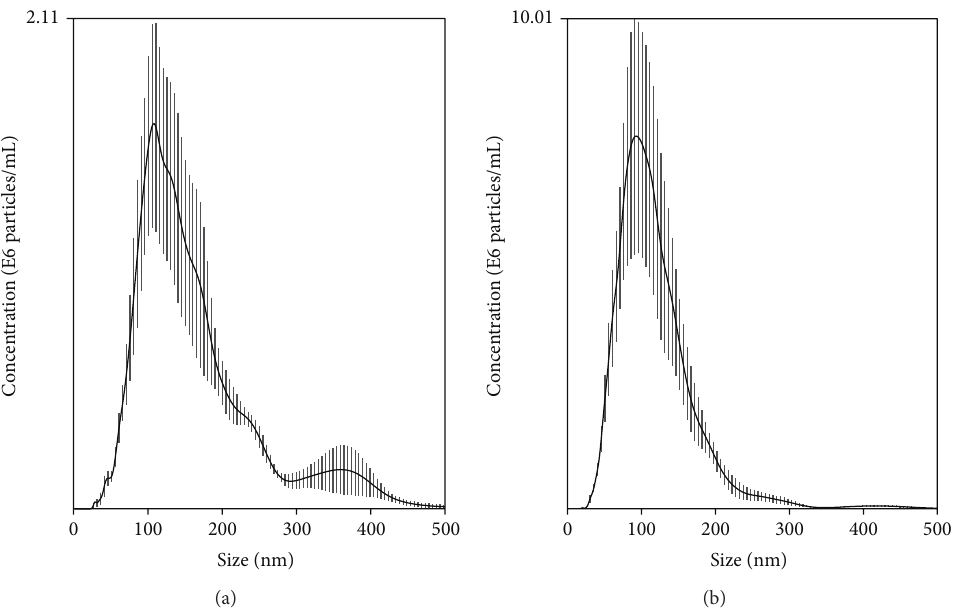
Figure 2: Examples of size distribution of PAD (a) and DACMC (b) nanoparticles.